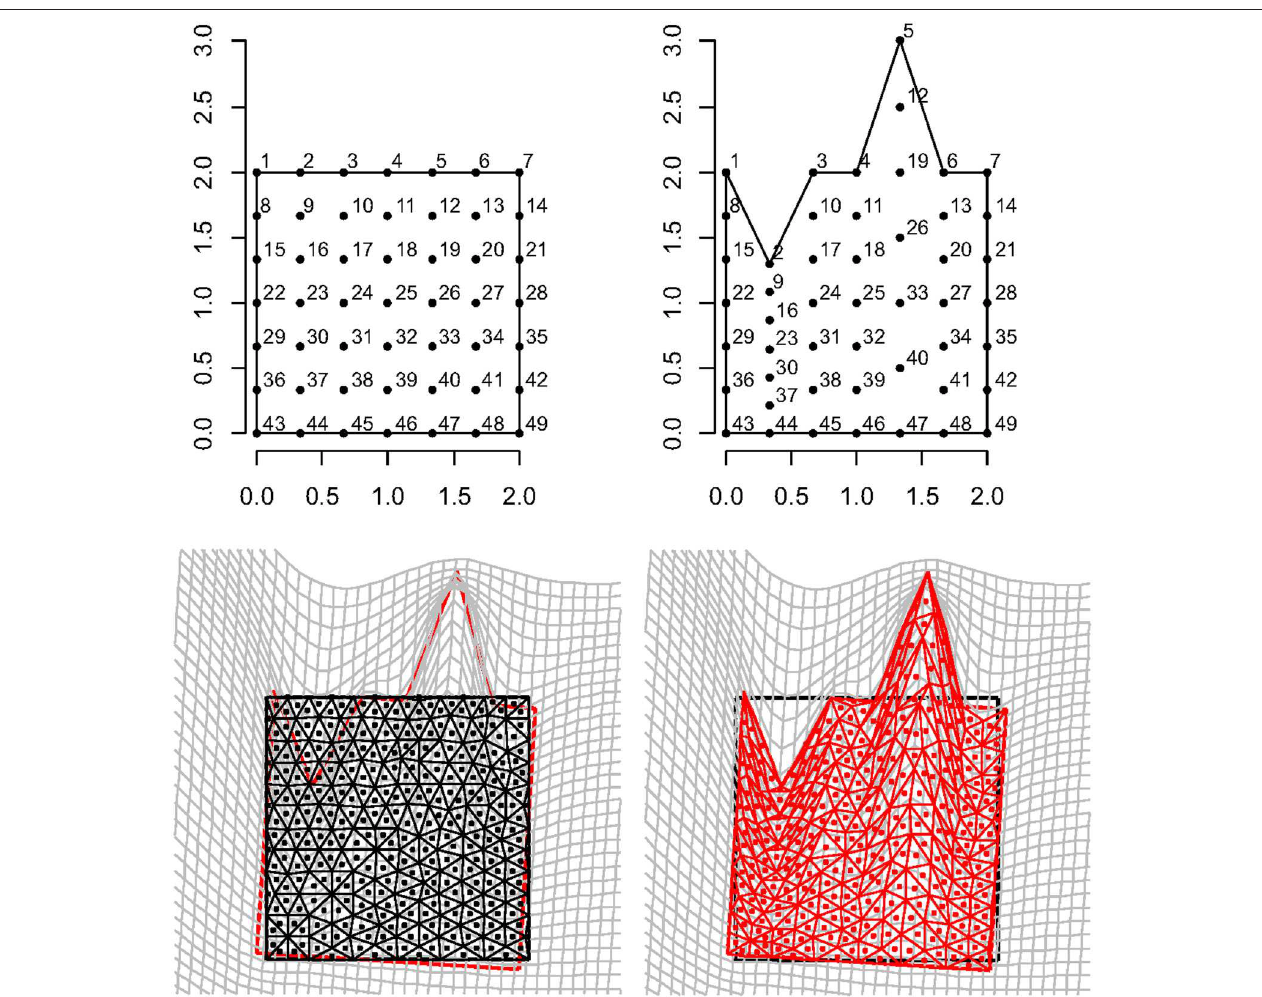
FIGURE 9 | Top row: a regular square grid (left) is deformed onto an irregular polygon (right) . Bottom row: a constrained Delaunay triangulation derived on the source shape (left) is estimated on the target using TPS; source and target shapes were aligned via OPA. Triangle’s centroids will be used as evaluation points for ( ψ ) , and other estimating F , ∇∇